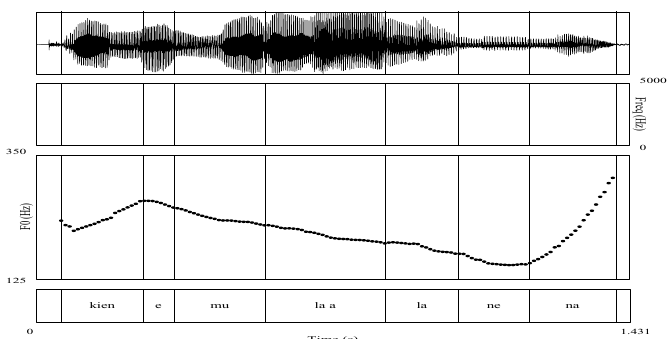
Figure 2. Waveform, spectrogram, and F0 (final rise) contour for ¿Quién emula a la nena? (Who emultates the girl?). F0 contour divided according to syllable